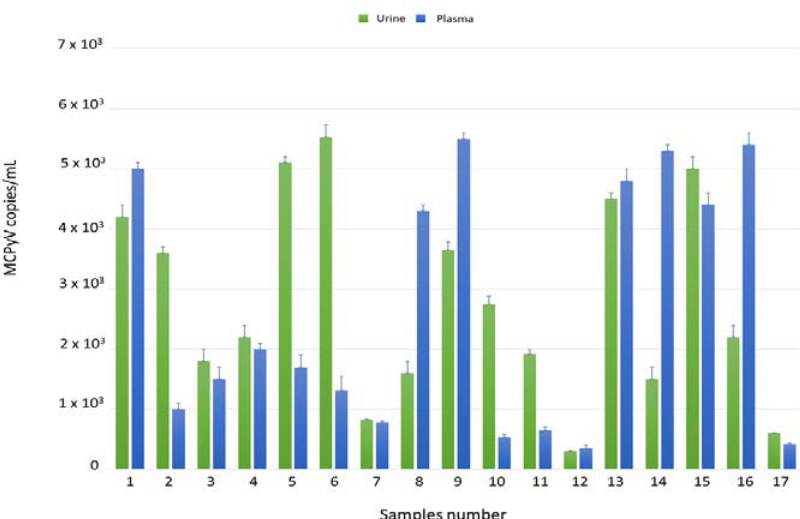
Figure 1. Detection and quantification of Merkel cell polyomavirus (MCPyV) DNA in urine and plasma ex vivo samples by qPCR. Data are expressed as the mean of three independent experiments, and error bars indicate standard deviations. MCPyV DNA ranged in urine from 3 × 10 2 copies / mL in MCPyV 12 to 5.5 × 10 3 copies / mL in MCPyV 6 and in plasma from 3.5 × 10 2 copies / mL in MCPyV 12 to 5.5 × 10 3 copies / mL in MCPyV 9.